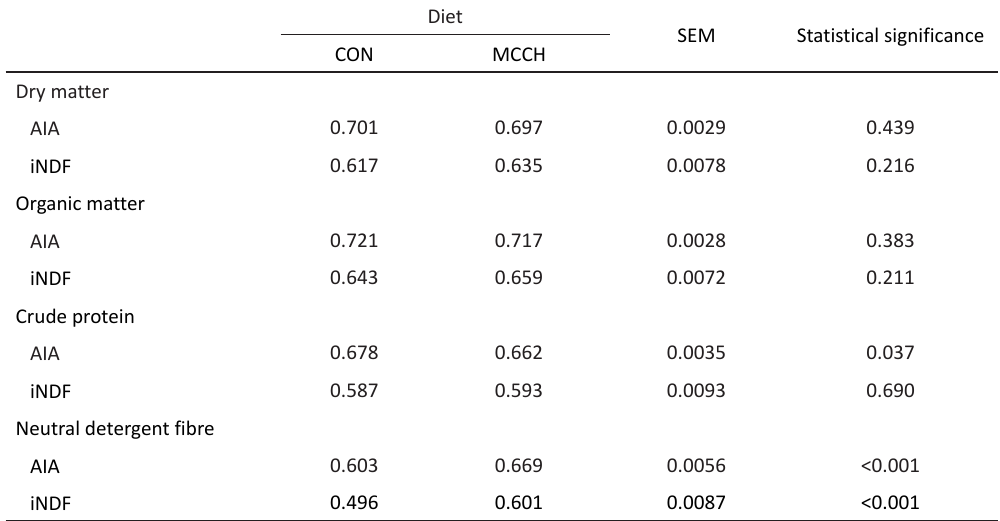
Table 6. Apparent diet digestibility of dairy cows fed microcrystalline cellulose (MCC) using acid insoluble ash (AIA) and indigestible NDF (iNDF) as internal markers Diet